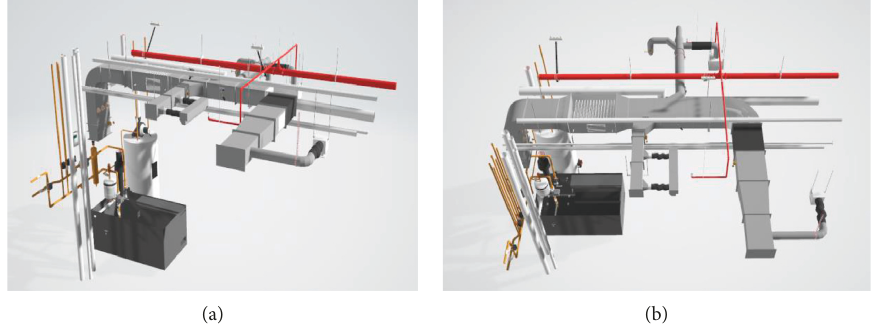
Figure 2: 3D model used in both visualization methods. Table 2: Prequestionnaire questions. Prequestionnaire questions (and response